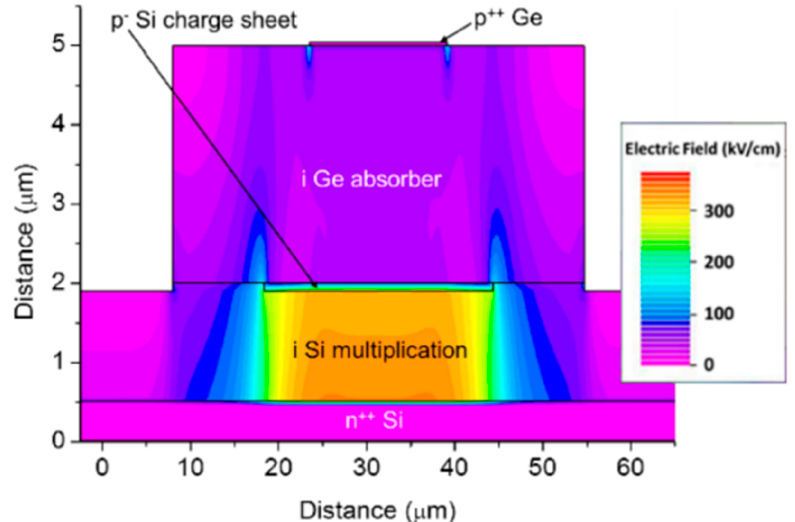
Figure 23. Electric field distribution for Ge/Si SPAD at 5% excess bias above the breakdown (the thickness of the Ge absorber is 2 μ m). Reproduced from [77], ROS Theses Repository, open access, 2019.